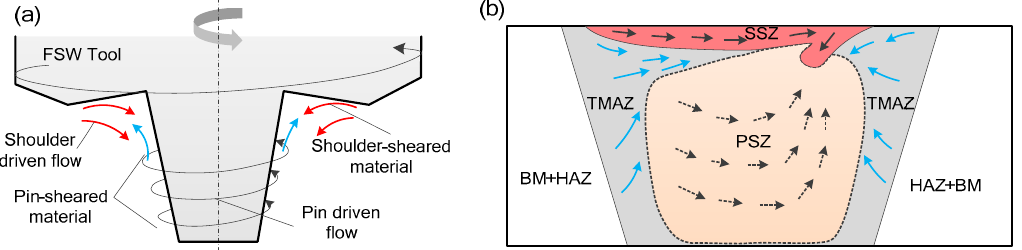
Figure 16. Plastic flow model of material in FSW process. ( a ) Schematic diagram of material plastic flow near FSW tool; ( b ) flow pattern of the joint deformation zone.